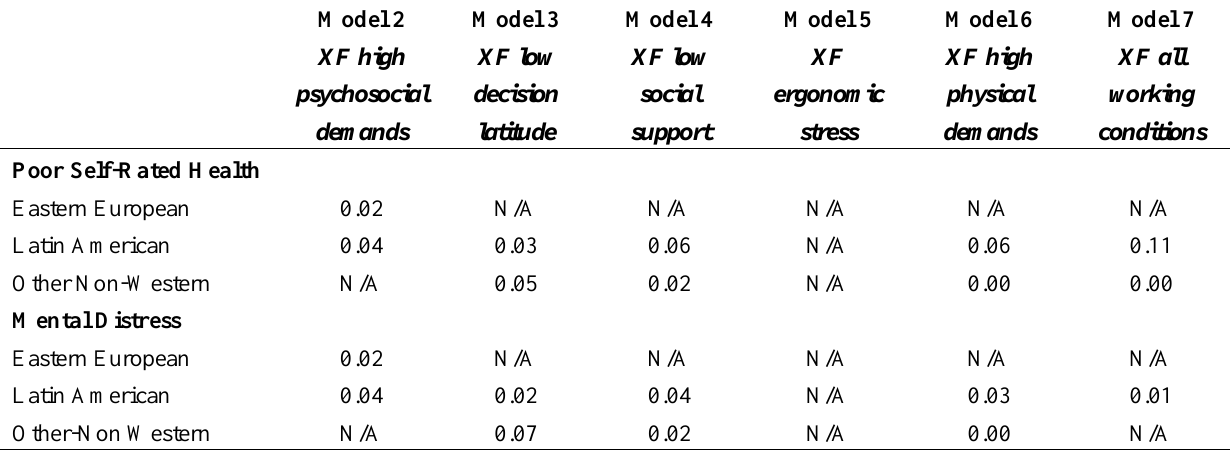
Table 4. Explained fractions (XF) calculations of the influence of adverse working conditions on odds ratios of poor self-rated health and mental distress among foreign background workers in Sweden